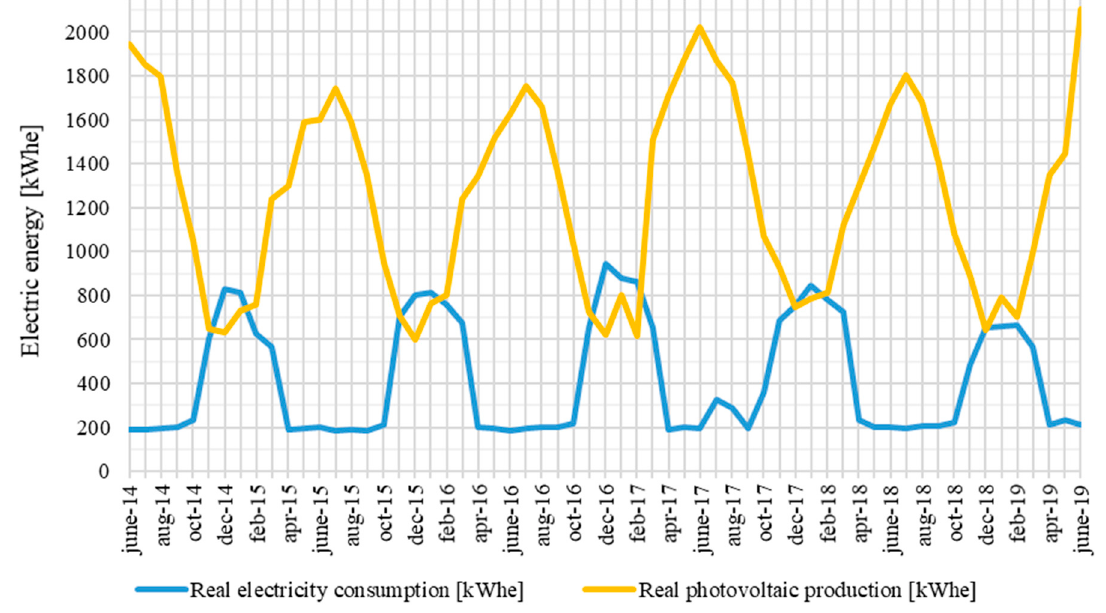
Figure 10. Comparison between real electricity consumption and photovoltaic production for the period June 2014–June 2019.